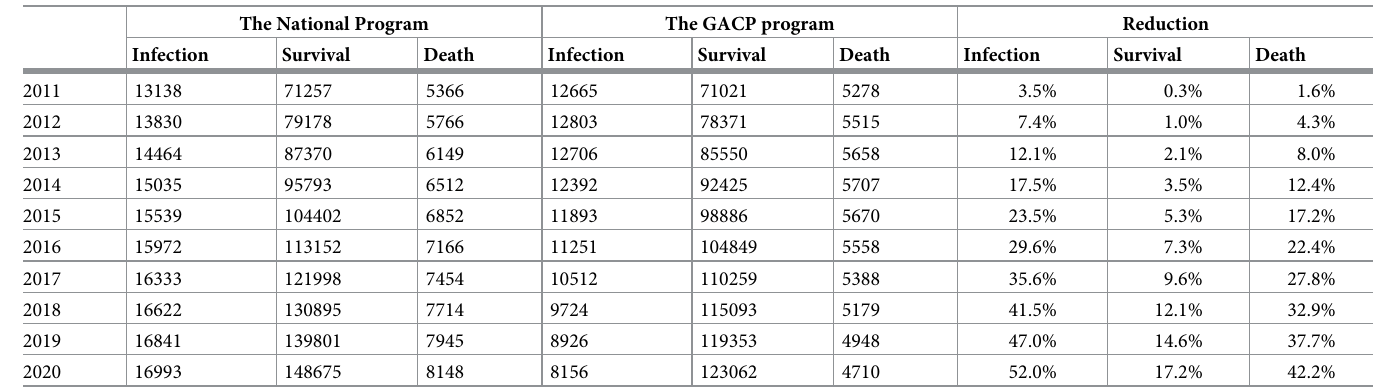
Table 4. Estimated data about new infections, survivals and deaths.